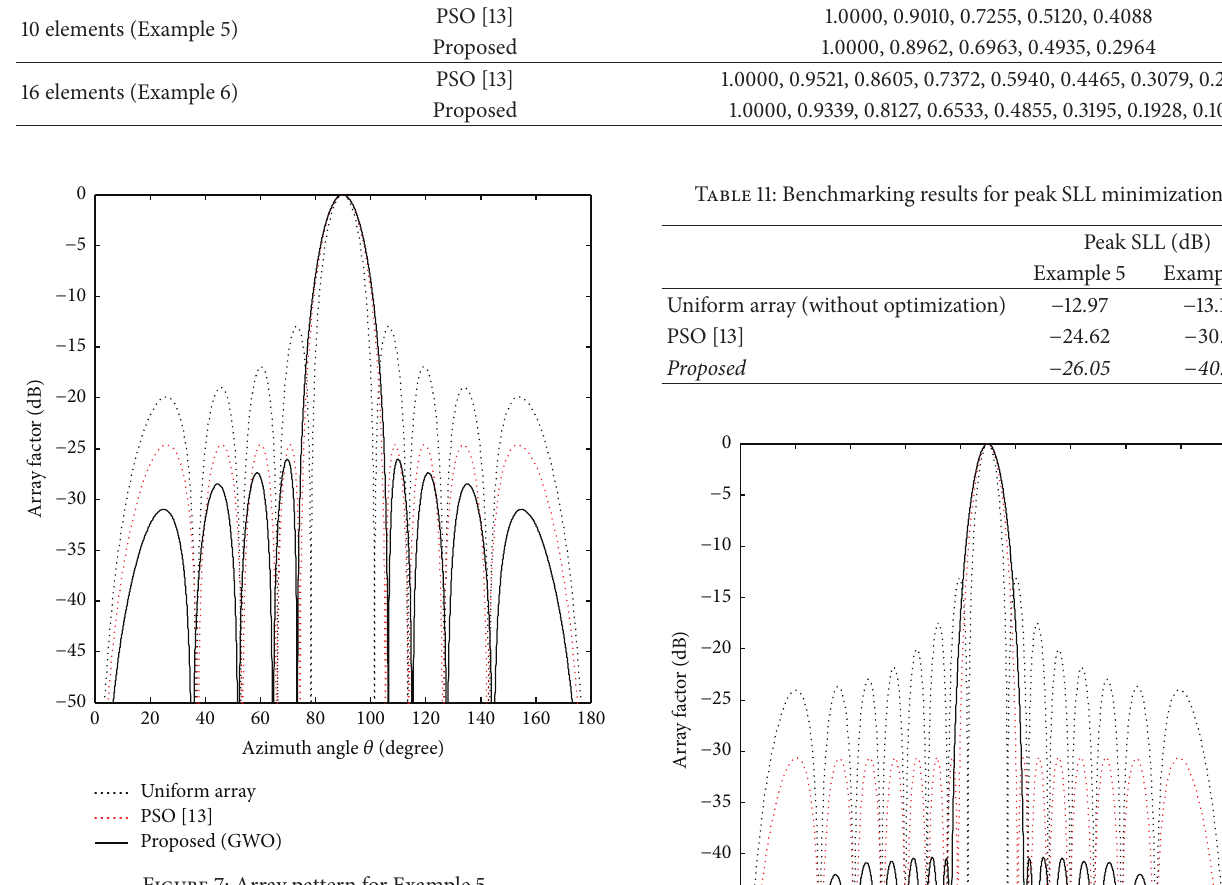
Figure 7: Array pattern for Example 5.